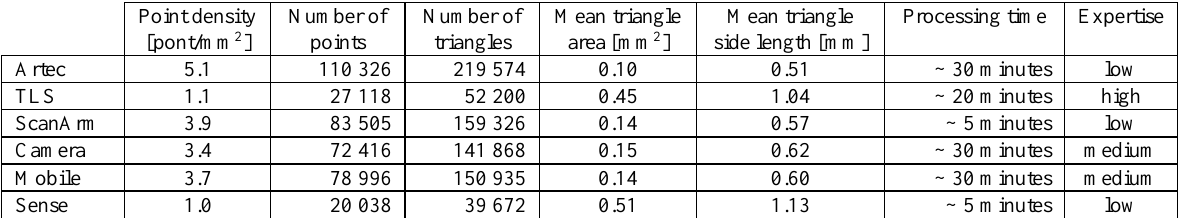
Table 2. Model parameters